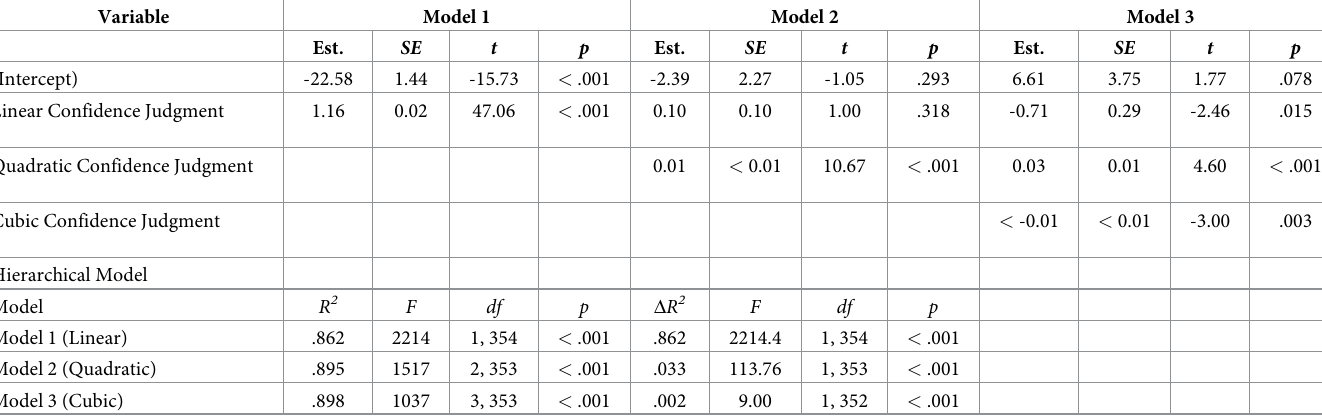
Table 1. Regression estimates and model comparisons of mean confidence judgments on the probability of recall.